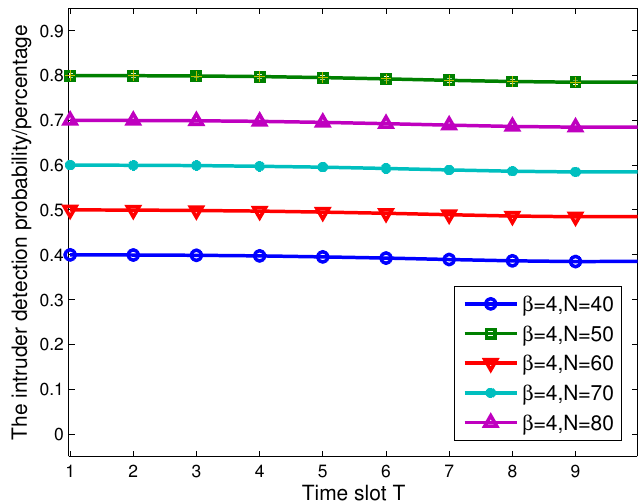
Figure 12. The intruder detection probability γ varies with T and N , which contains actuator nodes (ANs) and sensor nodes